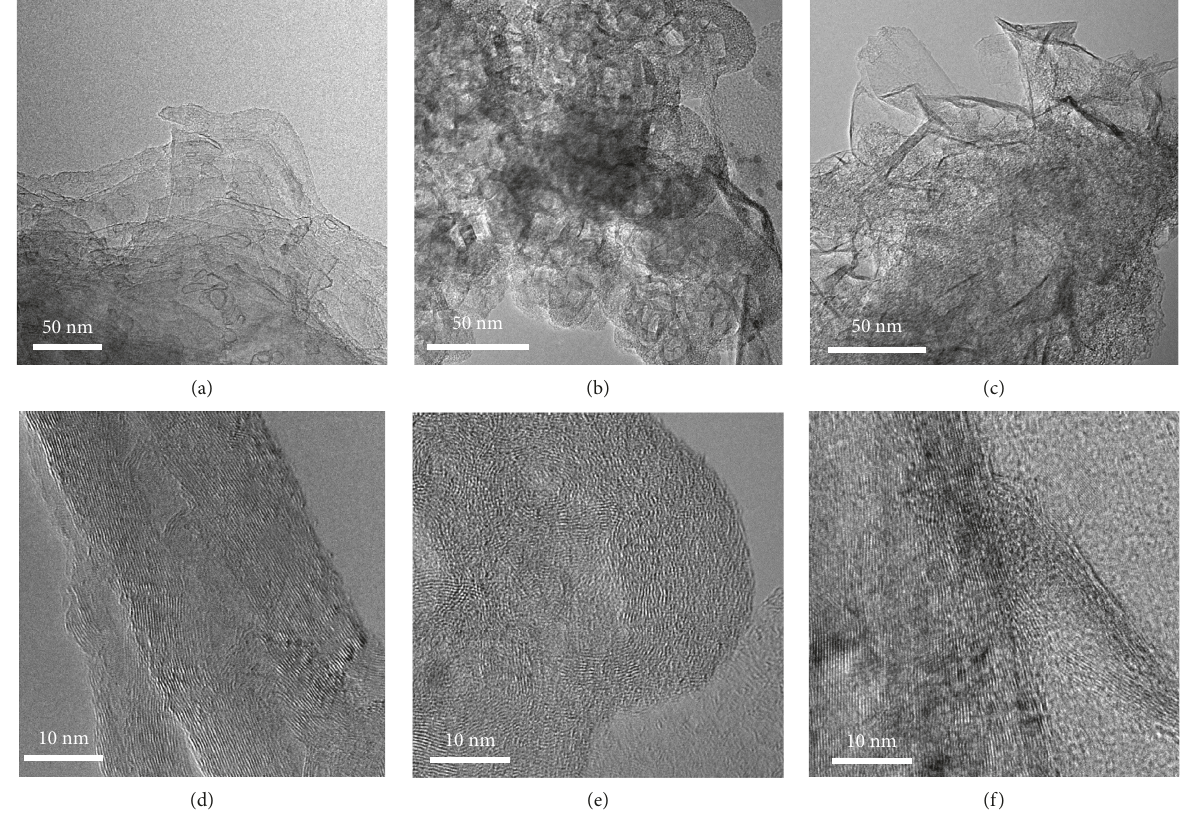
Figure 1: Transmission electron microscopy (TEM) images of (a, d) KAC-700, (b, e) KAC-800, and (c, f)